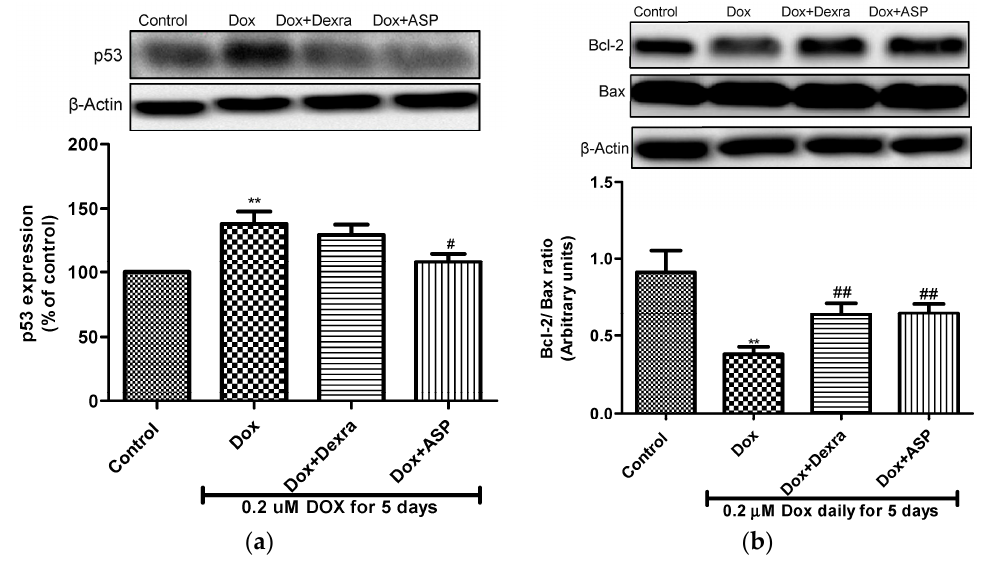
Figure 3. ( a ) The effect of aspalathin (ASP) on apoptosis proteins. ( a ) Represents the expression of p53 and ( b ) the expression of the Bcl-2/Bax ratio. H9c2 cells were treated with 0.2 µM Dox alone or in combination with either 20 µM dexrazoxane (Dexra) or 0.2 µM ASP daily for 5 days. Control samples were exposed to media only. Results are expressed as the mean ± SEM of three independent biological experiments, each with three technical replicates ( n = 9). ** p ≤ 0.01 versus control and # p ≤ 0.05, ## p ≤ 0.01 versus Dox.